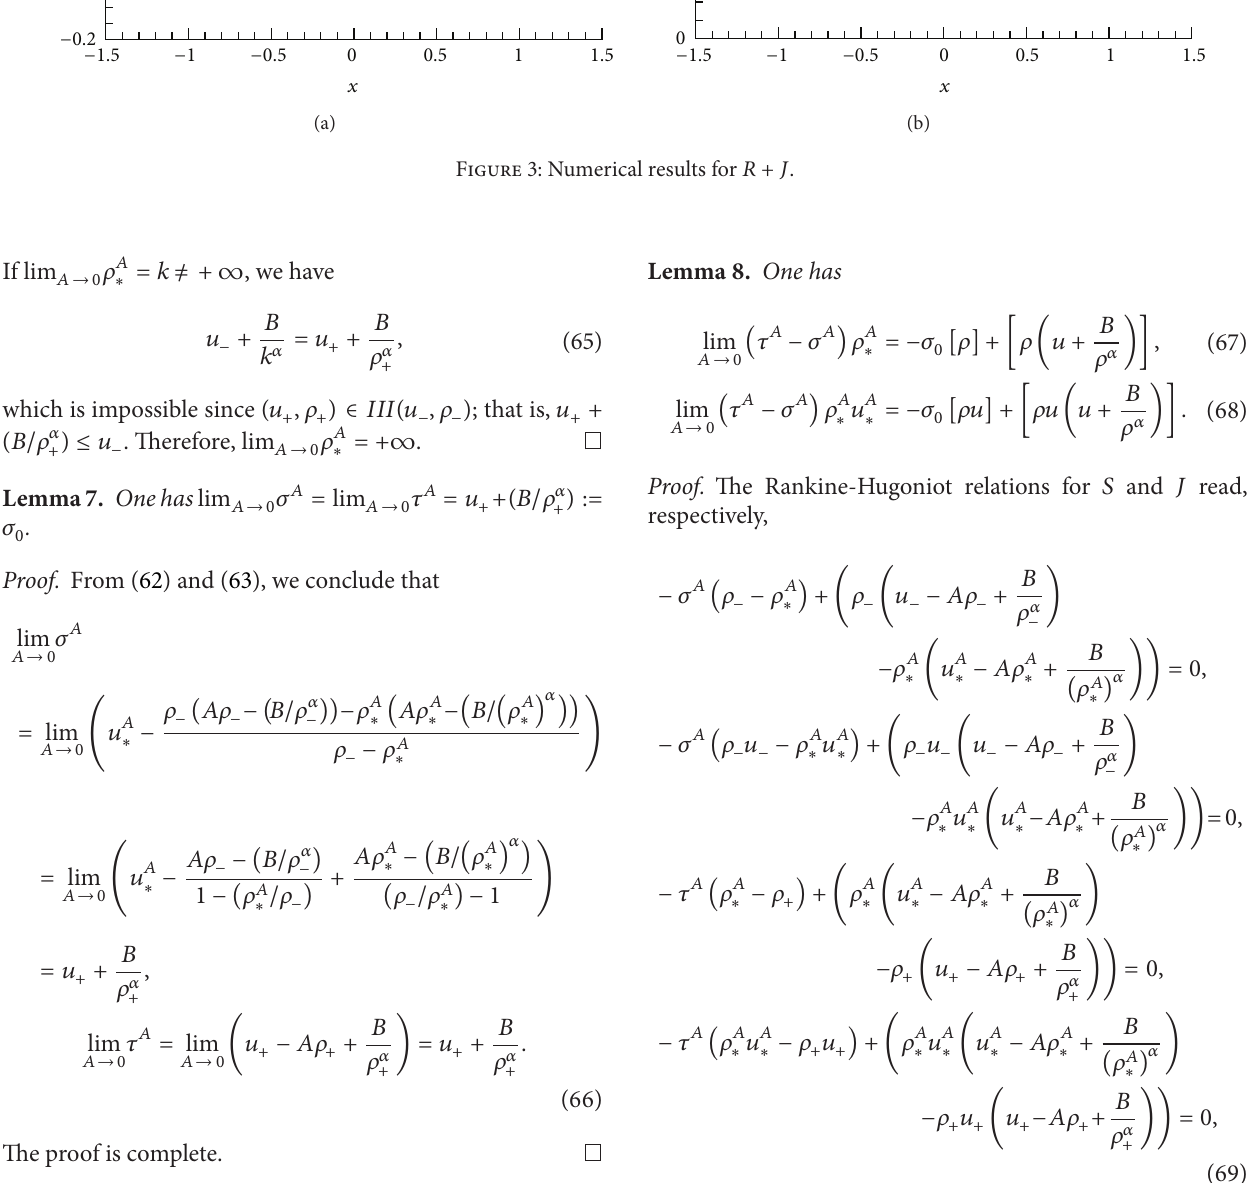
Figure 3: Numerical results for 𝑅 + 𝐽